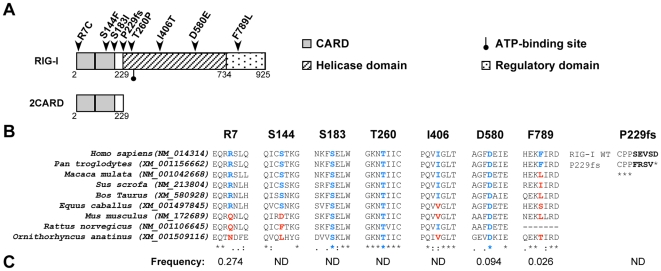
Genetic variability profile of human RIG-I.(A) Schematic representation of major domains of RIG-I (adapted from [7], [17], [34]). RIG-I non-synonymous SNPs described in NCBI SNP database are indicated as R7C (rs10813831), S144F (rs55789327), S183I (rs11795404), P229frameshift (fs) (rs36055726), T260P (rs35527044), I406T (rs951618), D580E (rs17217280) and F789L (rs35253851). (B) Alignment of protein sequence of RIG-I SNPs from human to platypus, using ClustalW software. Amino acids in blue and red correspond to conserved and non-conserved residues, respectively. (C) Frequency of RIG-I SNPs alleles. This latter information was collected from NCBI SNP database and refers to the sum of SNP containing alleles in both homozygous and heterozygous individuals for a given SNP. ND: not determined.